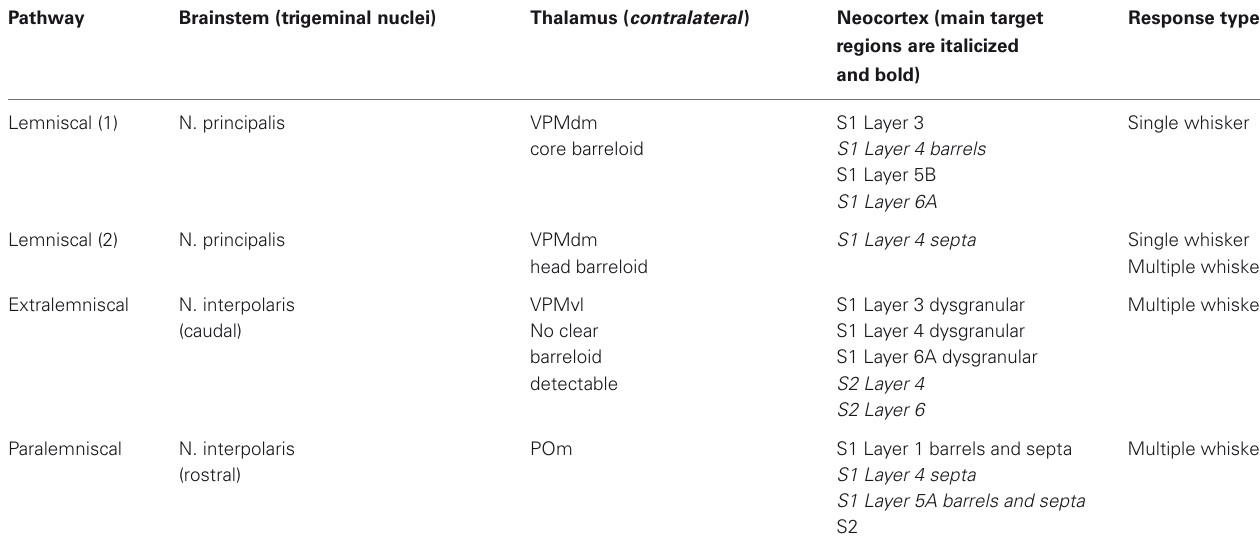
Table 1 | Pathways in the whisker-to-barrel cortex system.